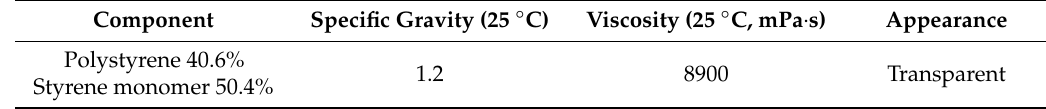
Table 3. Properties of Styrene-Based shrinkage reduction agent (SRA).